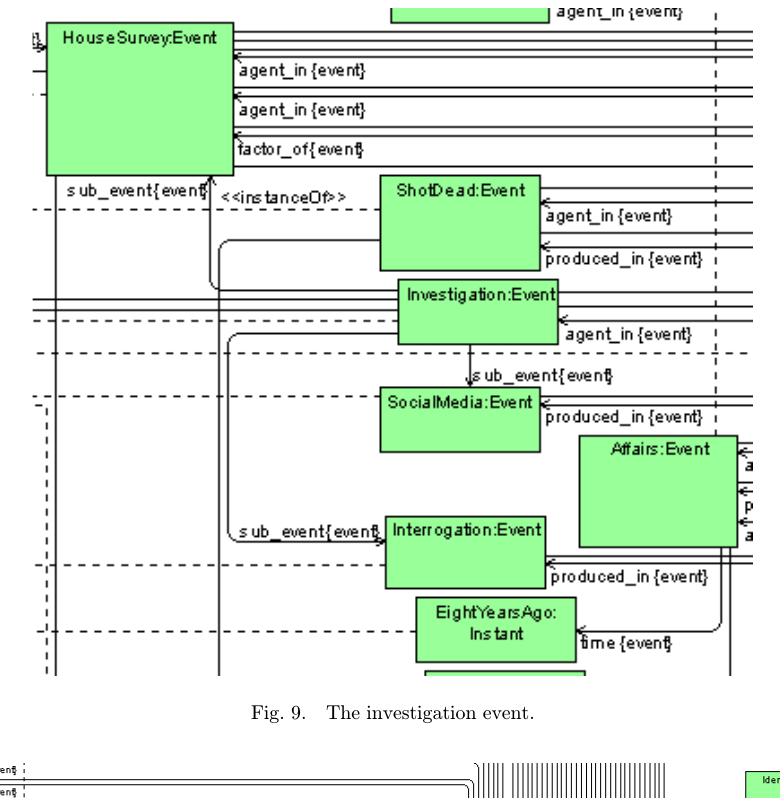
Fig. 9. The investigation event.